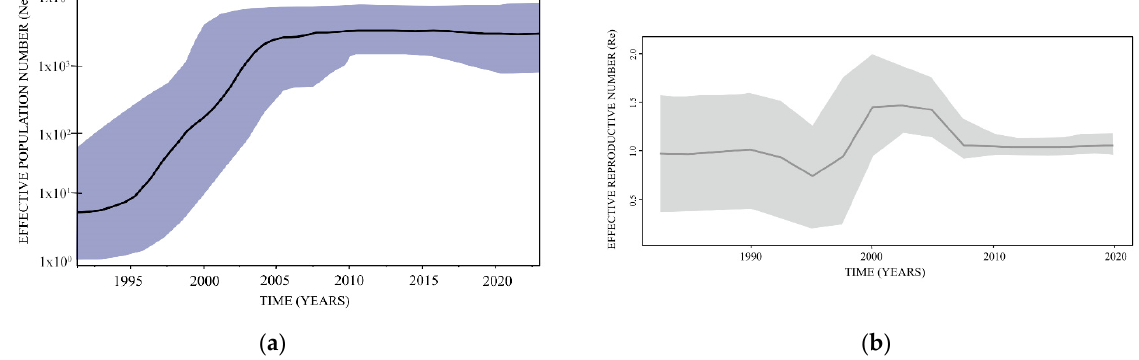
Figure 3. Bayesian skyline plot, representing estimation of the effective population growth of HIV subtype B in St. Petersburg (based on the ‘relaxed clock’ coalescent framework analysis on 198 sequences included in the study, in BEAST 1.10. software) ( left ); Effective reproductive number of the studied dataset of HIV subtype B in St. Petersburg, based on birth date skyline serial prior and 10 dimensions of Re in BEAST 2 software. Re plot was obtained in R software under the bdskytool software package ( right ).